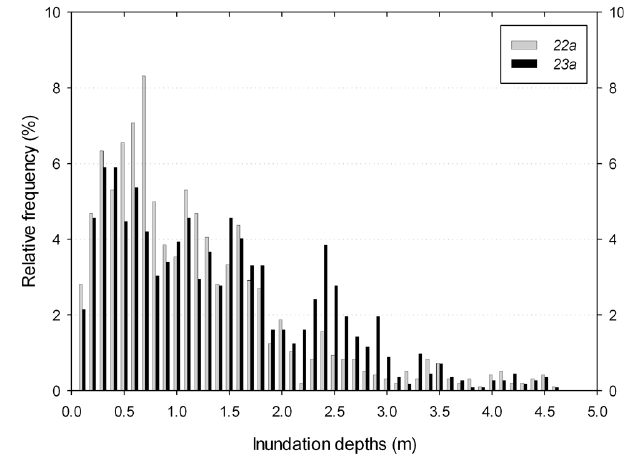
Fig. 3. Relative frequencies of the water depths (within a 10cm interval) in August 2005, simulated by the two hydraulic-simulation runs “22a” (dike heights as in 2005) and “23a” (dike heights as in 2005 but considering dike breaches). Note: only inundated grid cells within residential areas are analyzed in this